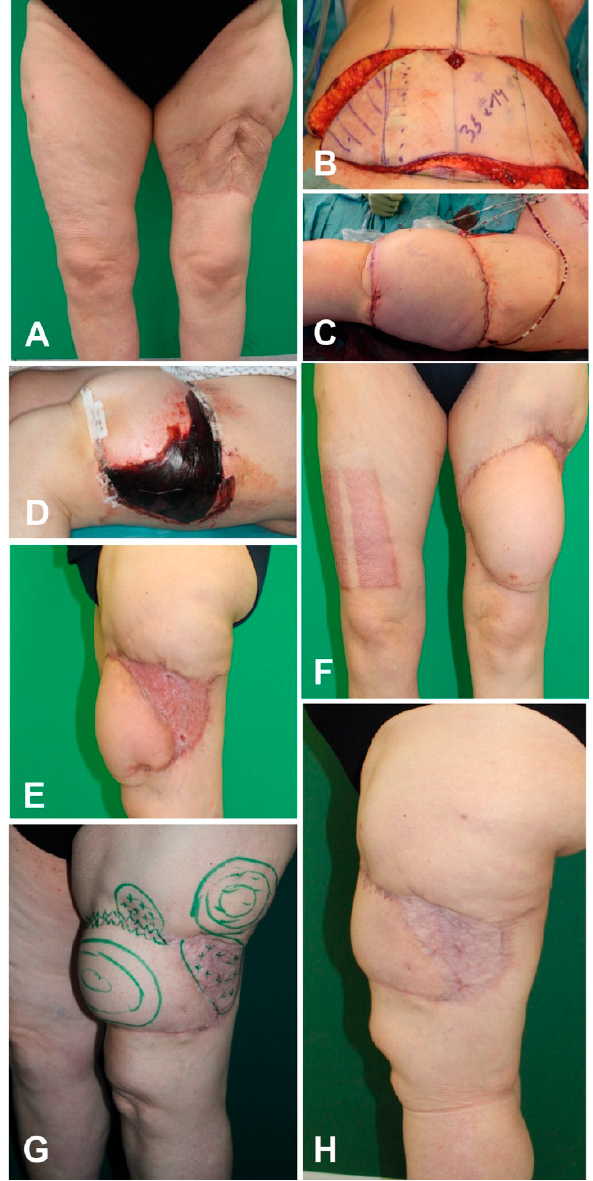
Figure 9. ( A ) Split-thickness skin graft scar, ( B) Preparation of a DIEP flap, ( C ) Covering of the soft-tissue defect after scar excision, ( D ) Development of flap margin necrosis, ( E , F ) Postoperative image after excision of flap necrosis and skin graft transplantation, ( G ) Preoperative planning of liposuction of the flap, ( H ) Final outcome. Table 1. Free flaps regarding tissue requirements after scar excision.